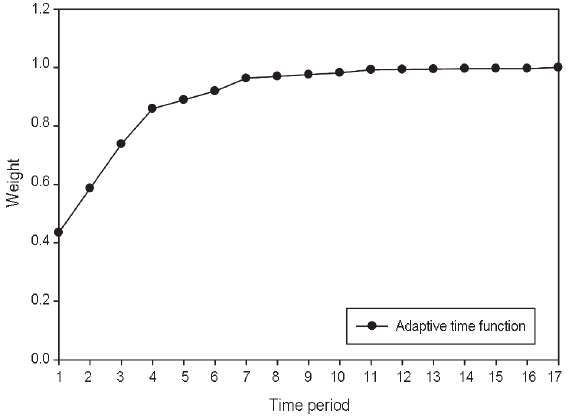
Fig. 4. Adaptive time